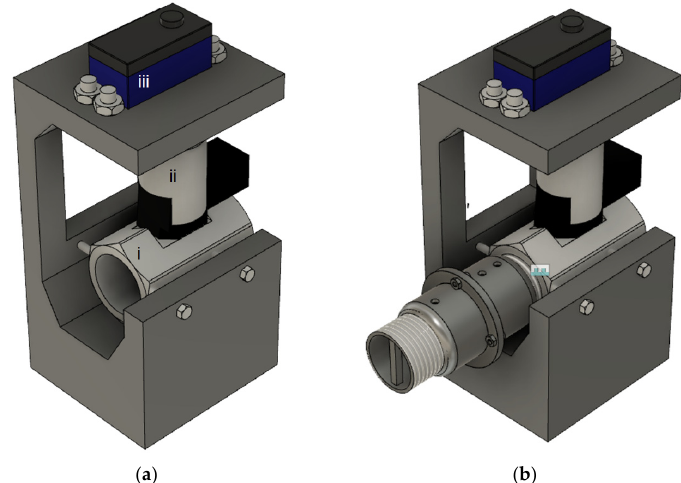
Figure 3. ( a ) Proportional controlled valve used to proportionally mix oxygen with air, where (i) is ball valve, (ii) is servo–valve coupling, and (iii) is servo motor. ( b ) Proportional controlled connected with integrated flow and pressure sensor.